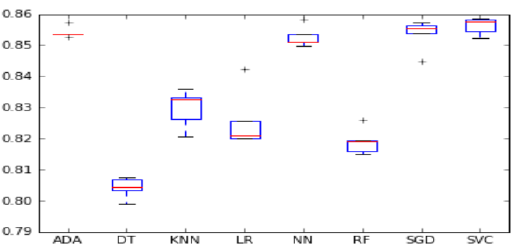
Figure 2. Algorithm F1-score comparison.